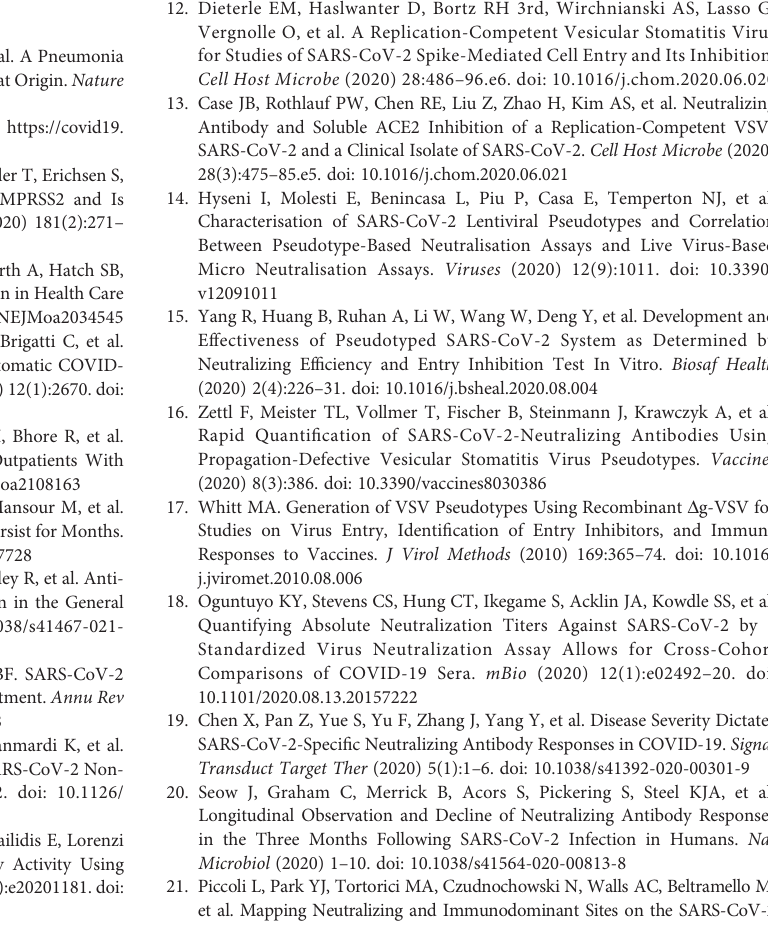
Supplementary Figure 1 | IgM and IgA titers in IgG negative COVID-19 patients from the cohort. (A) Spike and RBD IgM titers in patients #03, 14 and 50 who showed negative Spike and RBD IgG titers. (B) RBD IgA titers in patients #03, 14 and